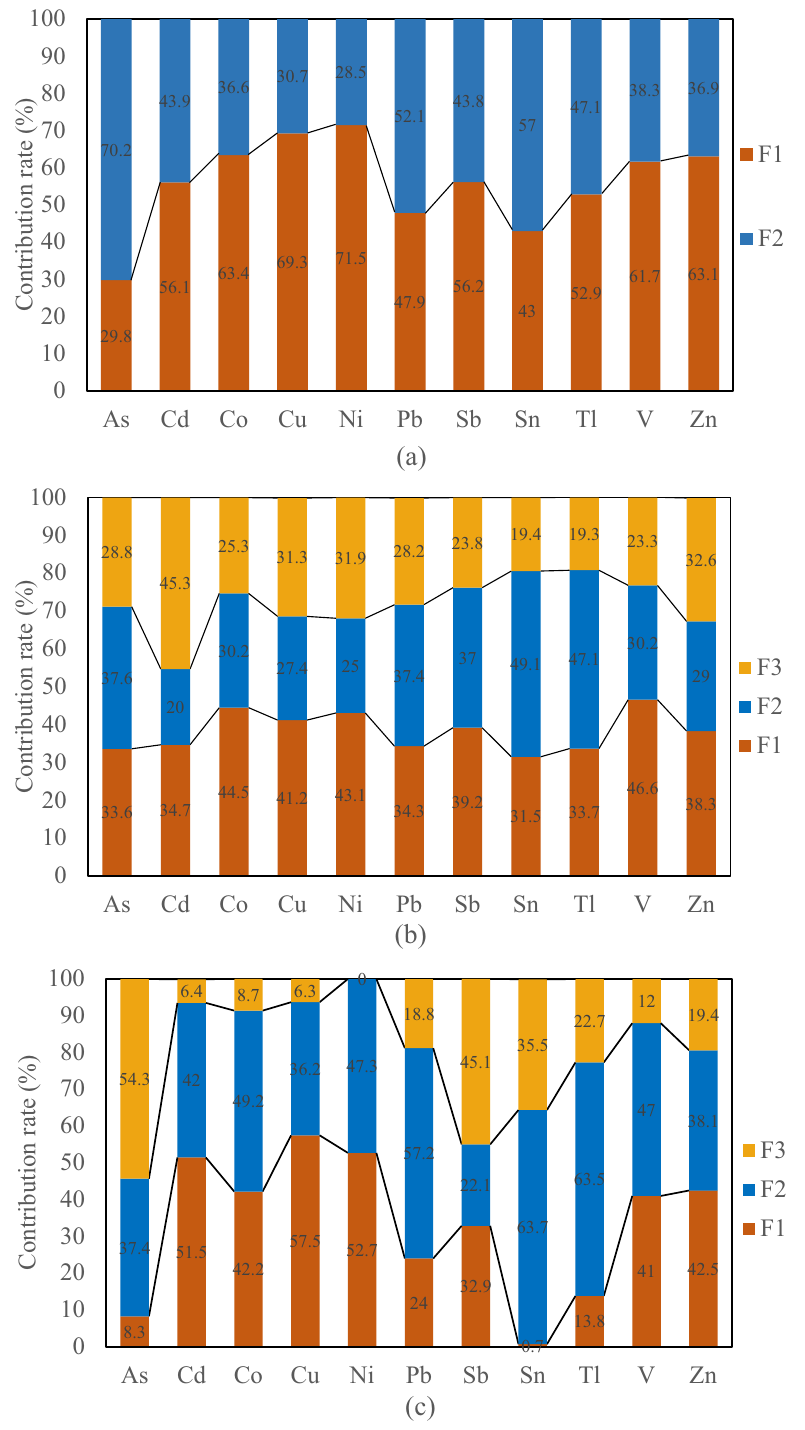
Figure 3. PMF analysis results of PTEs of agricultural soils in the Yarkant River Oasis ( a ), Kashgar Oasis ( b ) and Aksu Oasis ( c